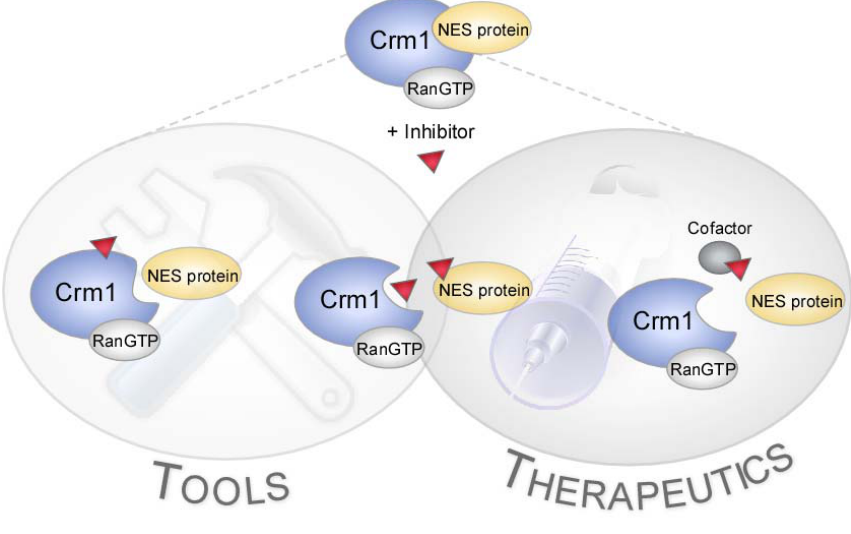
Figure 7. Model summarizing potential modes of action of the identified export inhibitors. Compounds may bind to CRM1 and, in an allosterical or competitive manner, affect its NES-binding domain, thereby preventing the assembly of a functional export complex. Alternatively, the compounds may directly interact with the specific NES itself or target putative cofactors required for the assembly of protein specific export complexes. Compounds displaying such a bioactivity profile would be of therapeutic